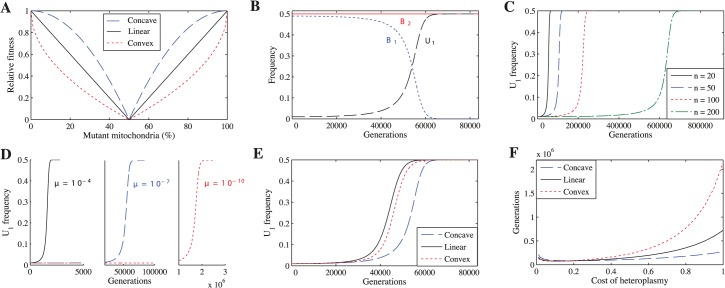
Uniparental inheritance replaces biparental inheritance for all tested parameter values.
(A) The three fitness functions when c
h = 1. Unless indicated otherwise, the parameters for B-F are n = 20, μ = 10−7, c
h = 0.2 and concave fitness. (B)
U
1 replaces B
1. (C)
U
1 takes longer to replace B
1 as n increases. (D)
U
1 takes longer to replace B
1 as μ decreases. (E)
U
1 replaces B
1 under all three fitness functions. (F) Number of generations for U
1 to replace B
1 across a range of costs of heteroplasmy. U
1 replaces B
1 even if the cost of heteroplasmy is extremely low.